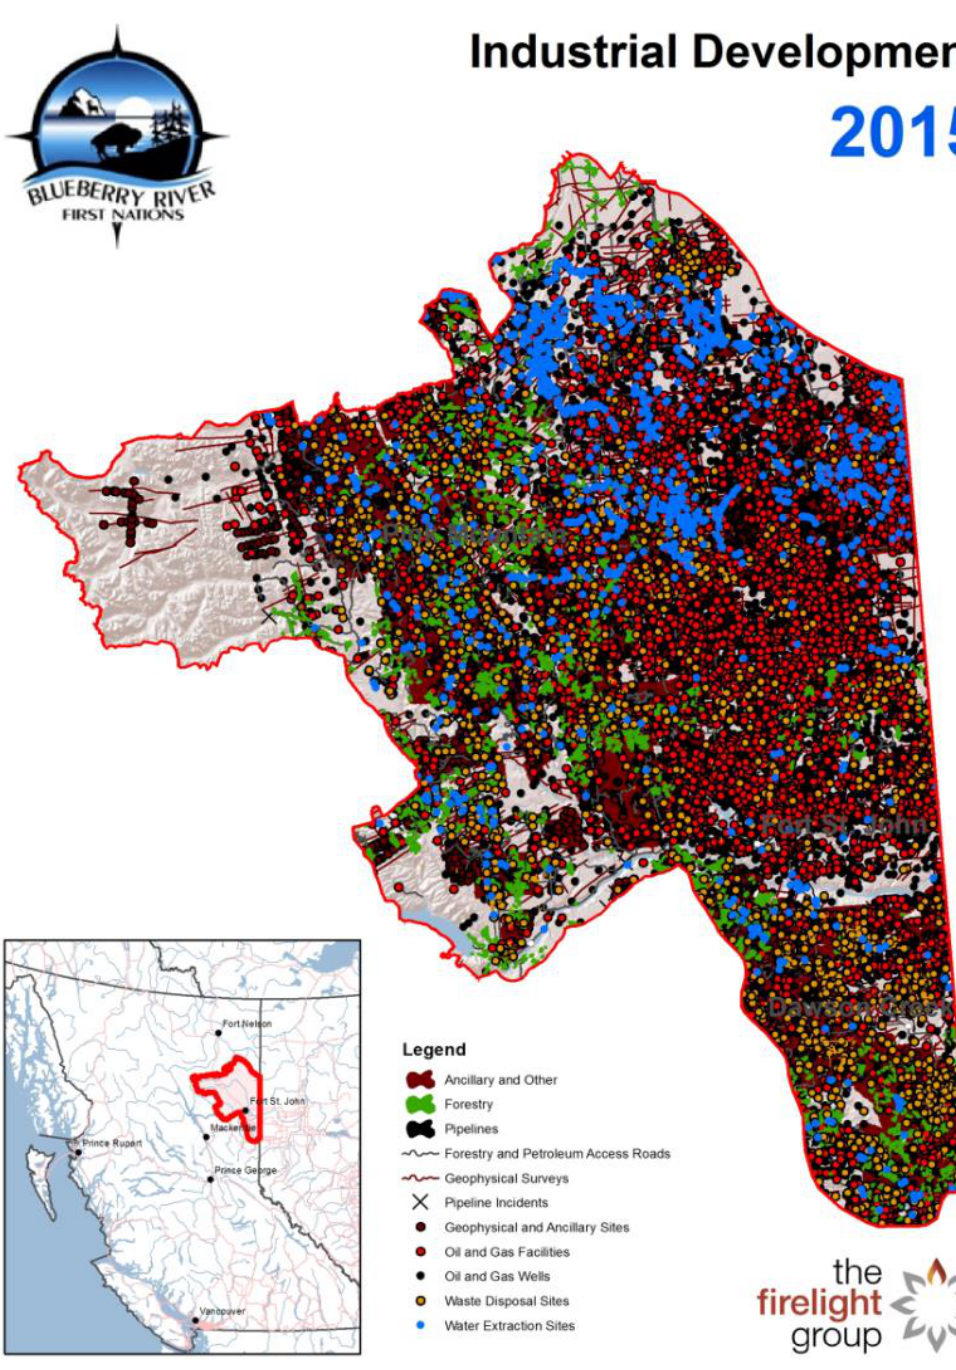
Figure 2. This map shows the cumulative impacts of industrial development activities in 2015 in the Blueberry River First Nations traditional territory